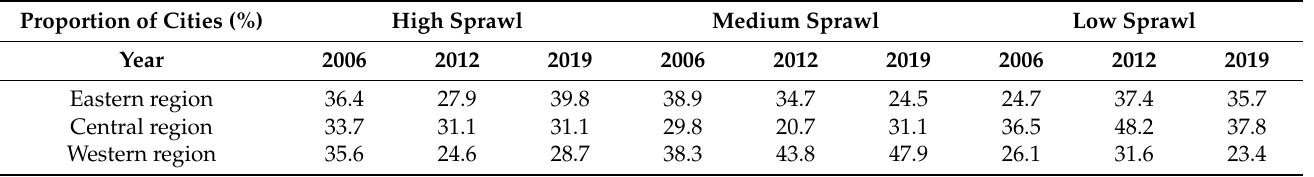
Table 2. The proportion of three types of cities in different regions. Figure 4. Average value of USI in different regions during the study period.